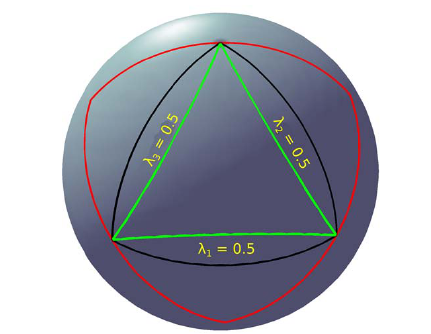
Figure 8. Ultraviolet (UV)-isoline and great circle arc.